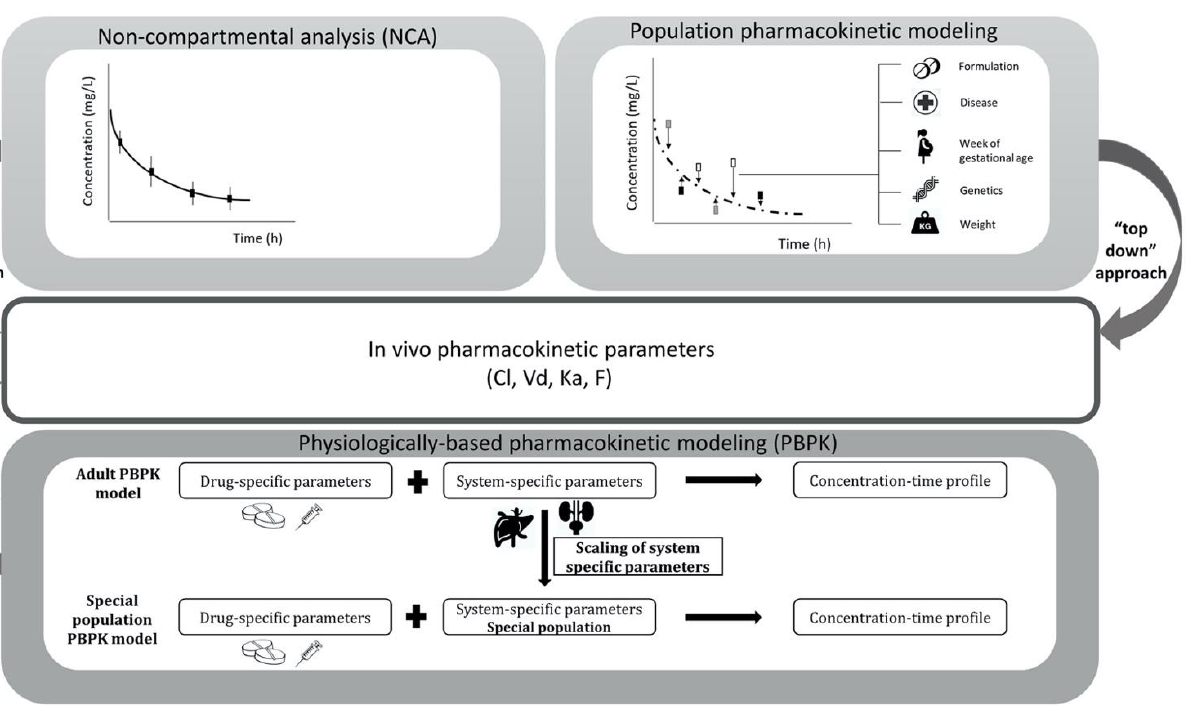
Figure 2. Pharmacometric tools used to support pharmacokinetic analysis in pregnant women, divided in the following two modelling approaches: “top-down” and “bottom-up” approach. “Top-down” approach is often referred to as non-compartmental analysis and population pharmacokinetic modelling, while “bottom-up” approach is physiologically based pharmacokinetic modelling. CL = clearance, Vd = volume of distribution, Ka = absorption rate constant, F = bioavailability.